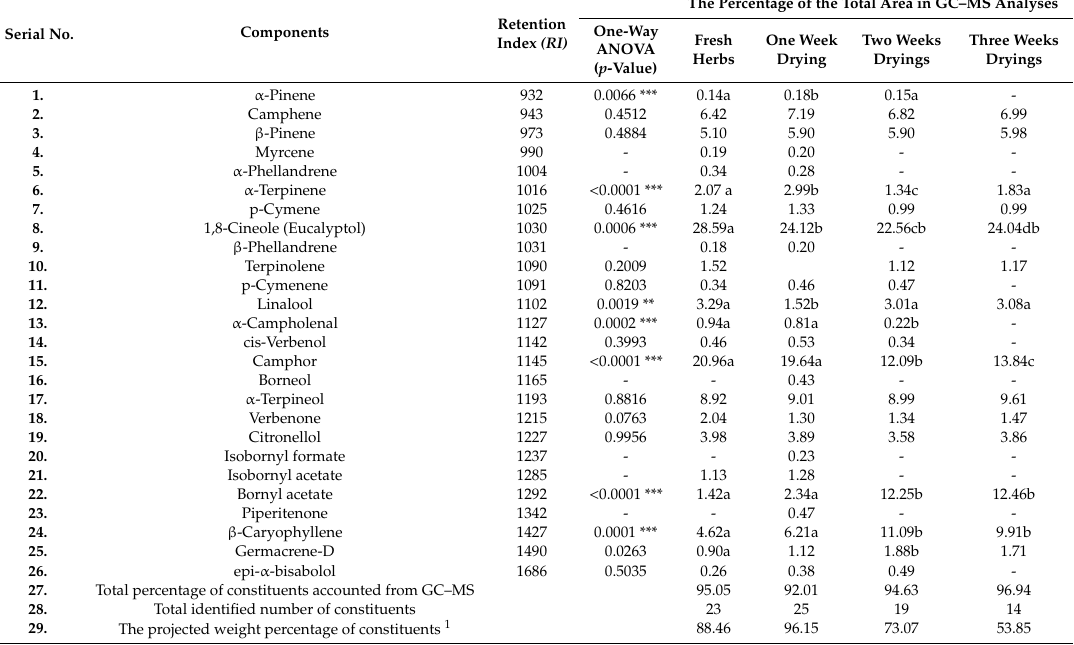
1 The statistically projected yields are based upon extractions of all 26 constituents versus the concurrent constituents present in each of the oil samples. Statistical significance of an ANOVA: ** p < 0.01; *** p < 0.001. Tukey’s multiple comparisons were performed for the constituents that were statistically significant using a one-way ANOVA. Di ff erent letters within the same constituent row denoted significant di ff erences between the time points, according to Tukey’s test ( p <